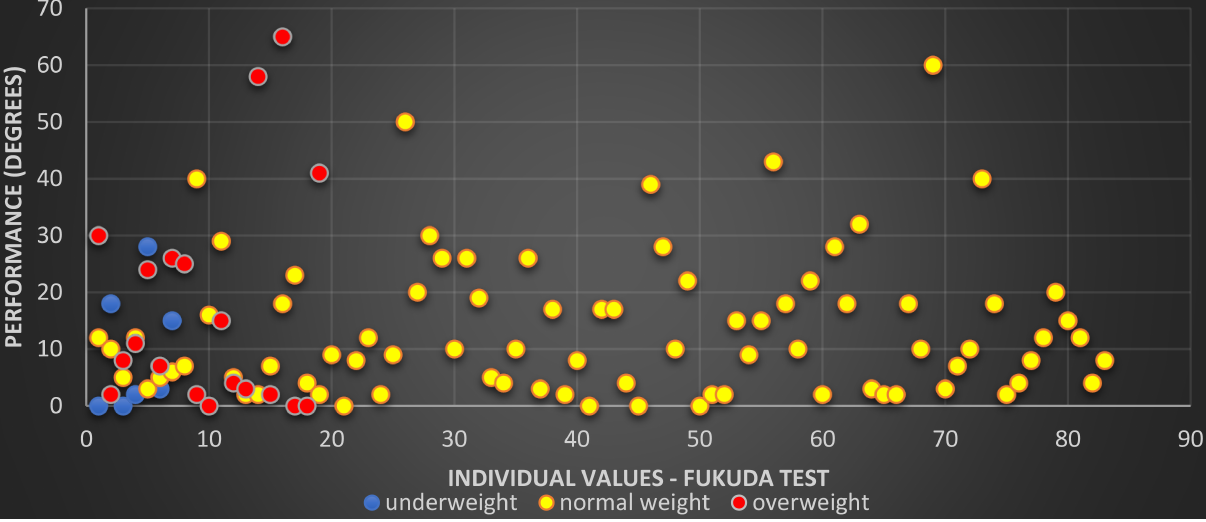
Fig. 2. Dynamics of individual performance at the level of the 3 BMI groups for the Fukuda